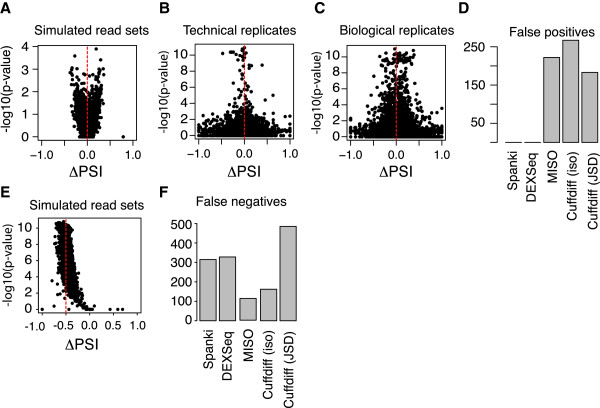
Variation in Percent Spliced-In (PSI) and error rates. Volcano plots where ΔPSI is plotted against the –log10 p-value of the Fisher’s Exact Test, to assay variation due to sampling and sequencing error in simulations (A), technical RNA-Seq replicates (B), and biological replicates (C). (A) Plot comparing two simulated read sets of equal reads per kilobase (300 Reads Per Kilobase). Since transcript abundances are equal, expected ΔPSI is zero. (B) Variation in ΔPSI between replicate RNA-Seq runs of the same libraries. (C) Variation in ΔPSI between independent biological samples, each with a distinct RNA-Seq library. Results within each sex were similar, results for female samples shown. (D) False positive differential splicing calls in a null dataset. Cufflinks results are shown for both splicing analysis (Jensen-Shannon Divergence, JSD), and isoform abundance comparison. MISO results shown are based on isoform-centric analysis. (E) Volcano plot of ΔPSI calculated by Spanki for false negative analysis, comparing simulated datasets with PSI = 0.25 and PSI = 0.75 respectively, for 1644 events (expected ΔPSI = -0.50, red line). (F) Counts of false negatives for differential splicing calls in simulated data with an input ΔPSI = -0.50.